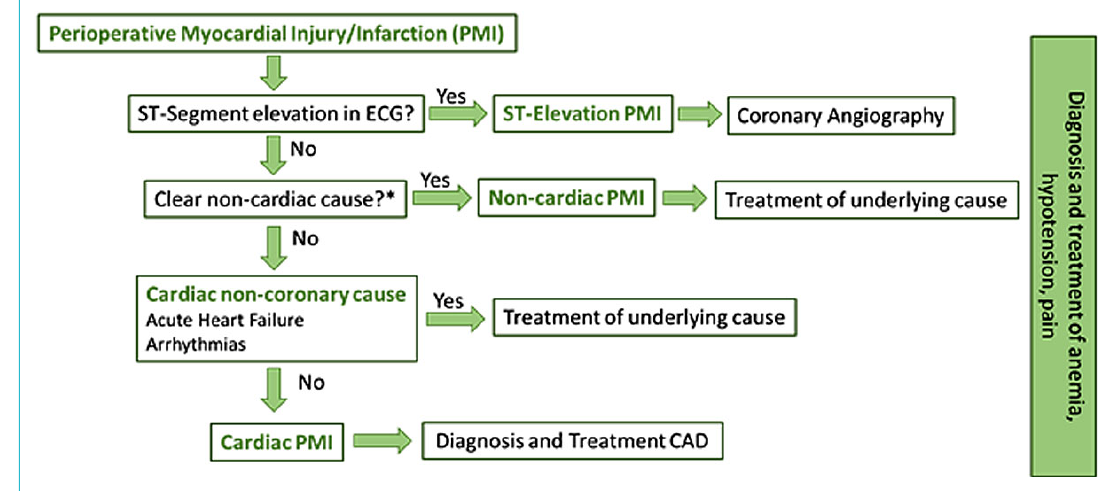
Figure 3: Flowchart for classification of perioperative myocardial infarction/injury.* Sepsis, cardiac trauma, stroke, pulmonary embolismECG = electrocardiogram; PMI = perioperative myocardial infarction/injury; CAD = coronary artery